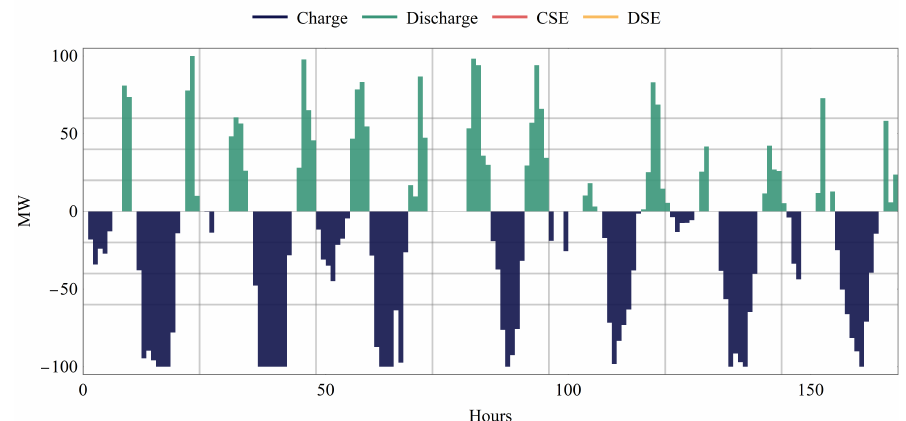
Figure 8. LAES charging-discharging, sample week of summer 2030, basic model.